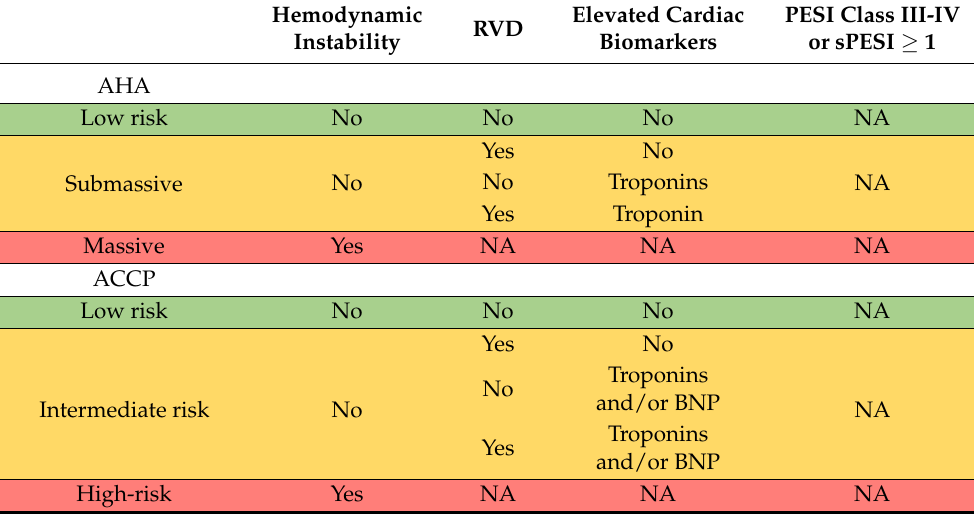
Table 1. Definitions of submassive/intermediate-risk PE demonstrating the variable inclusion of RVD and cardiac